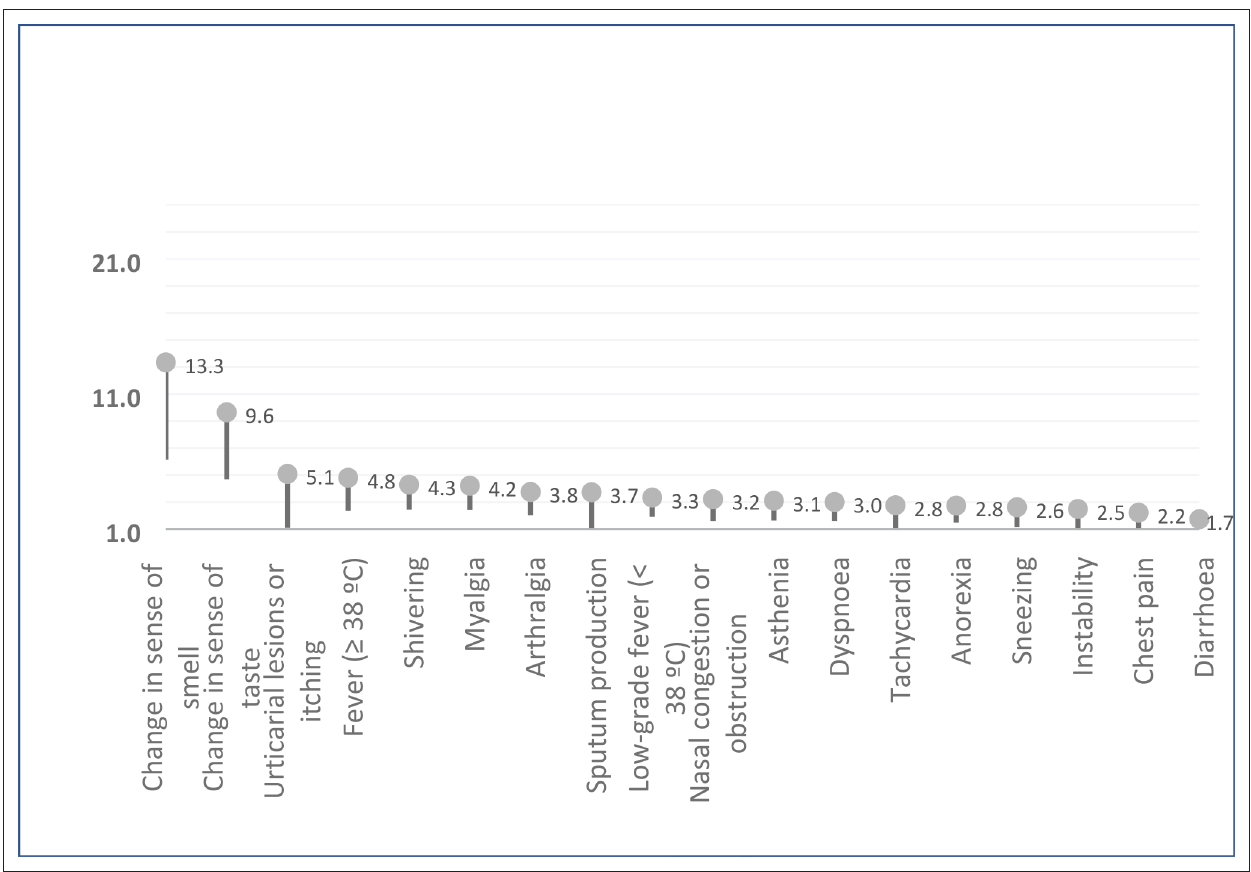
Figure 2 Association between symptoms and odds ratio of SARS- CoV- 2 infection in 226 healthcare workers in central Catalonia who were evaluated by reverse transcription- polymerase chain reaction (RT-